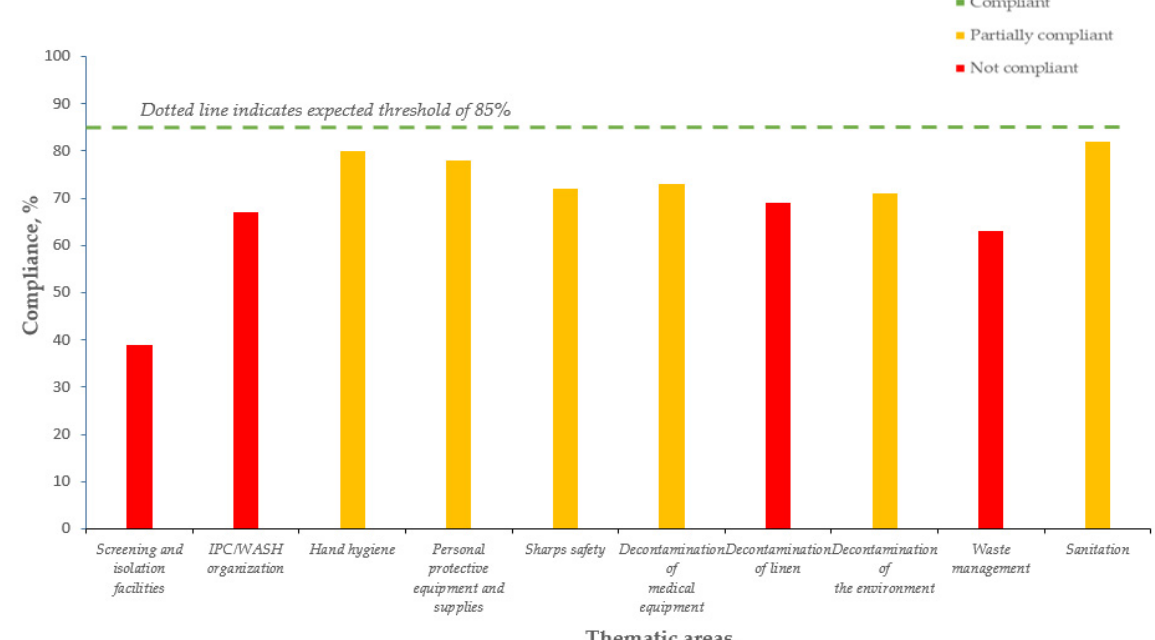
Trop. Med. Infect. Dis. 2021 , 6 , x FOR PEER REVIEW 9 of 15 Figure 3. Average yearly IPC/WASH compliance (average of quarterly scores for the year, three quarters assessed) in the 10 thematic areas, Community Health Posts, Kenema district, Sierra Leone (2018). Table 4. Average yearly compliance in relation to scores on a National IPC/WASH 1 assessment tool in Maternal and Child Health Posts, Kenema district, Sierra Leone (2016–2018).